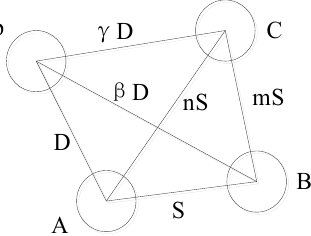
Figure 1. The distance between each phase cable core of a single-core cable.